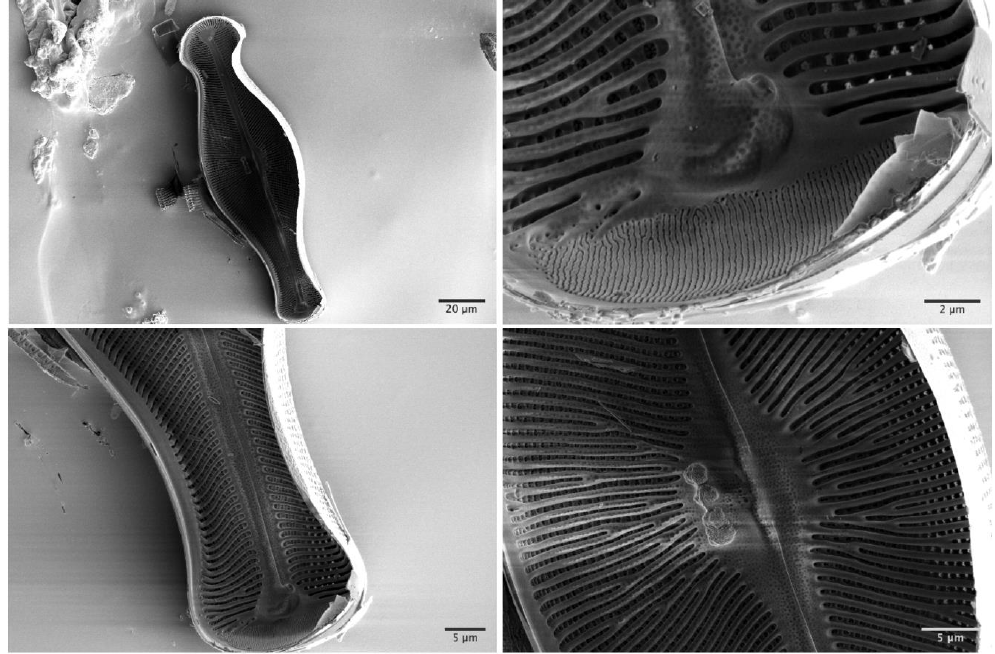
Figure 3. Scanning electron microscopy images of inner structures of Didymosphenia geminata after the epivalve part was separated from the hypovalve